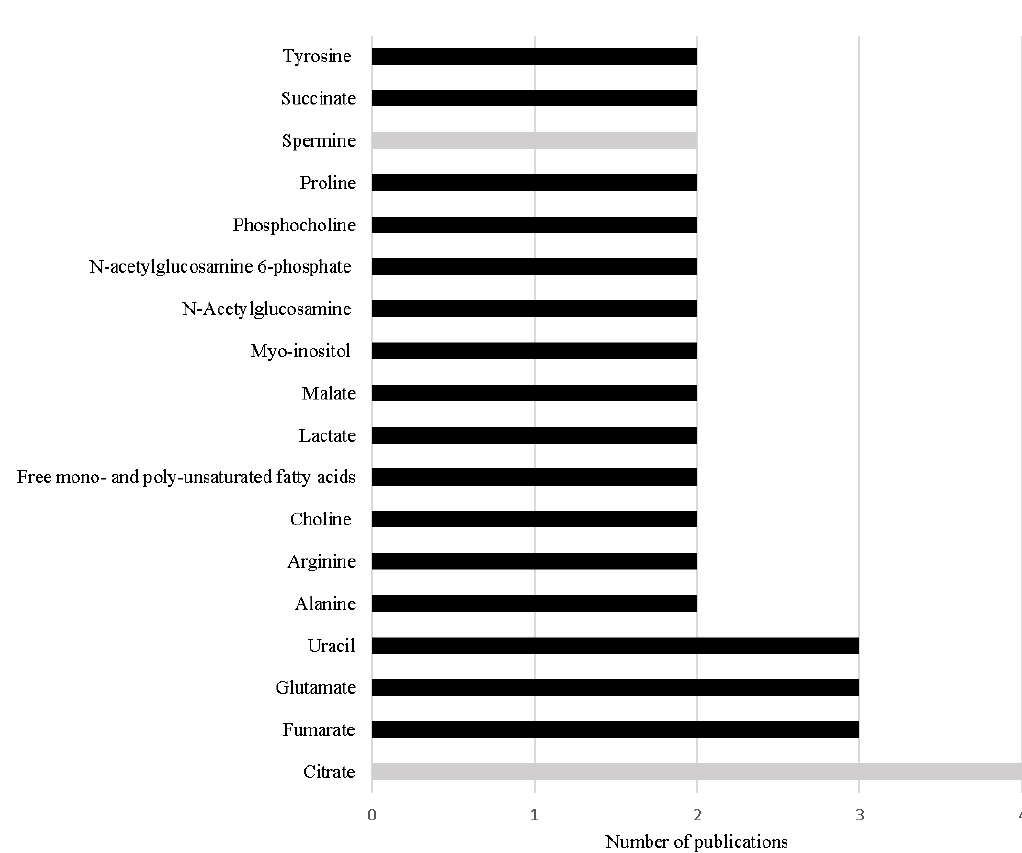
Figure 2. Metabolites referred with the same variation in more than one study performed in PCa tissue in the last 5 years. The black bars represent metabolites increased in PCa and the grey bars represent metabolites decreased in PCa.